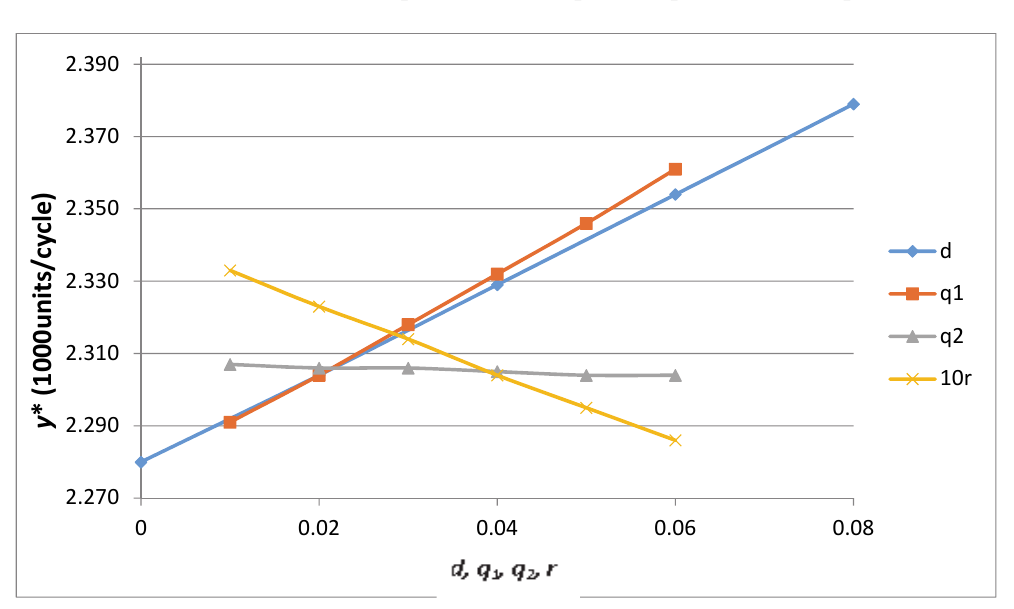
Fig. 8. Effect of increase in different parameters viz. d, q 1 , q 2, r on